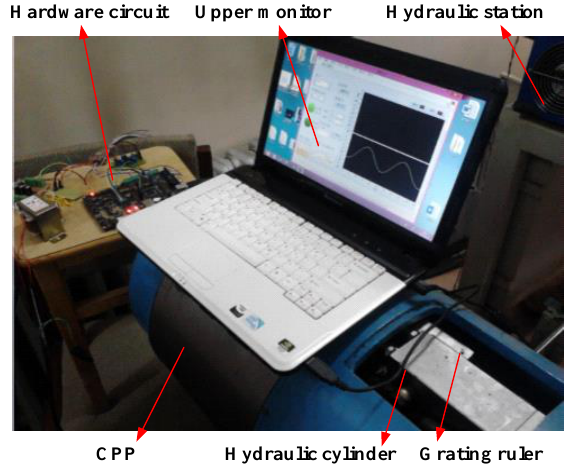
Figure 9. System structure of the scale model.